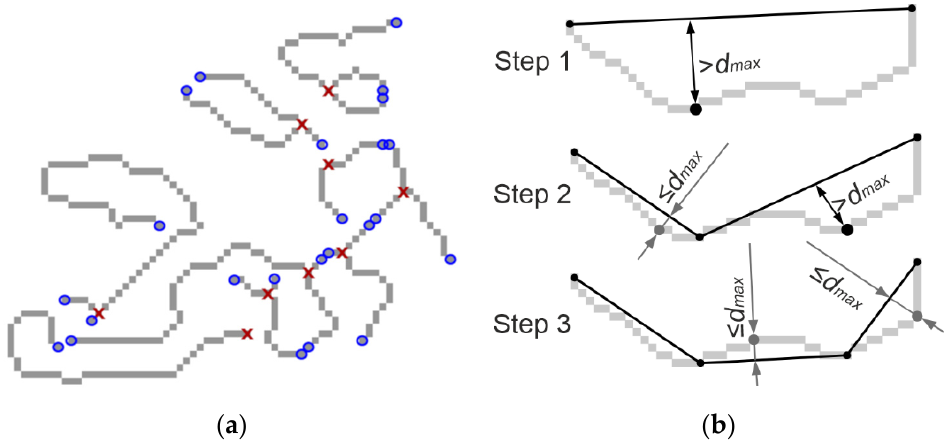
Figure 6. The process of parametric contours building: ( a ) extraction of branch points (red crosses) and of edge points (blue dots) from discrete edge map; ( b ) recursive multistep process to split pixel chain and construct polyline: at each step split point is selected in pixel with maximum distance to the line, if this distance exceeds the d max threshold.